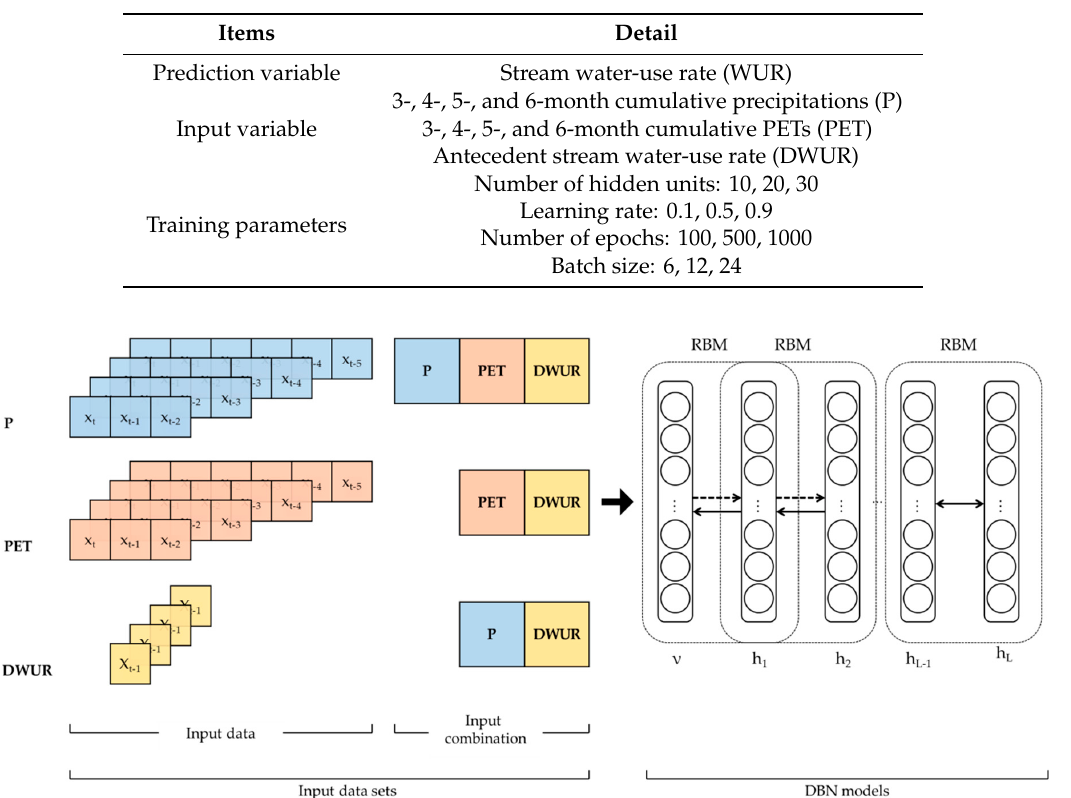
Table 1. Description of deep learning parameter settings.